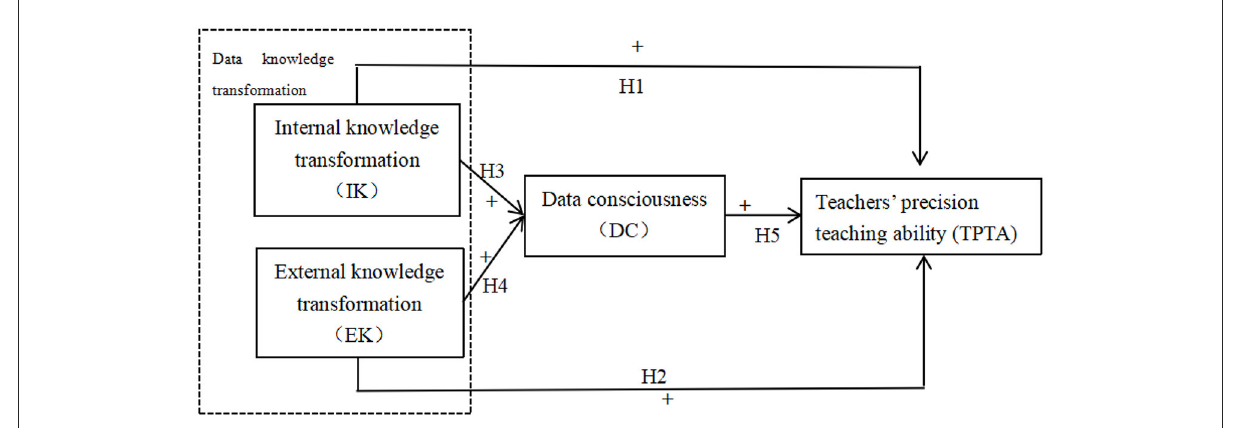
FIGURE1 A theoretical model of data knowledge transformation, data awareness, and teachers’ precision teaching